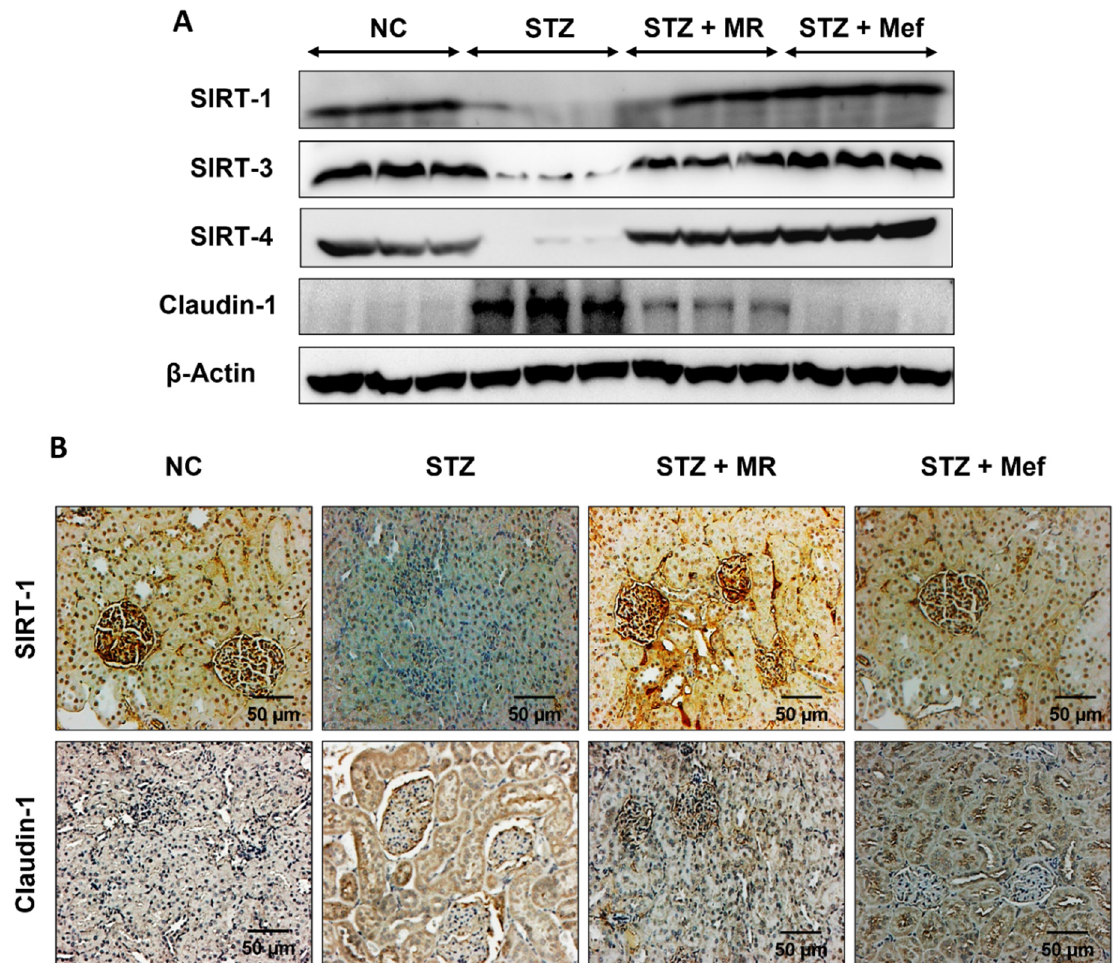
Figure 5. Effects of MR extract on SIRTs and claudin-1 expression in the kidneys of diabetic rats. ( A ) western blotting analysis of SIRT1, SIRT3, SIRT4, and claudin-1 expression. β -Actin expression was used as the loading control. The results represent three independent experiments. ( B ) Immuno- histochemical analysis of SIRT-1 and claudin-1 in the kidneys of mice with STZ-induced diabetes. Original magnification: 200 × , scale bar: 50 µ m. NC: Normal control, STZ: streptozotocin-treated group, STZ + MR: Streptozotocin-treated rats received MR extract, STZ + Mef: Streptozotocin-treated rats received